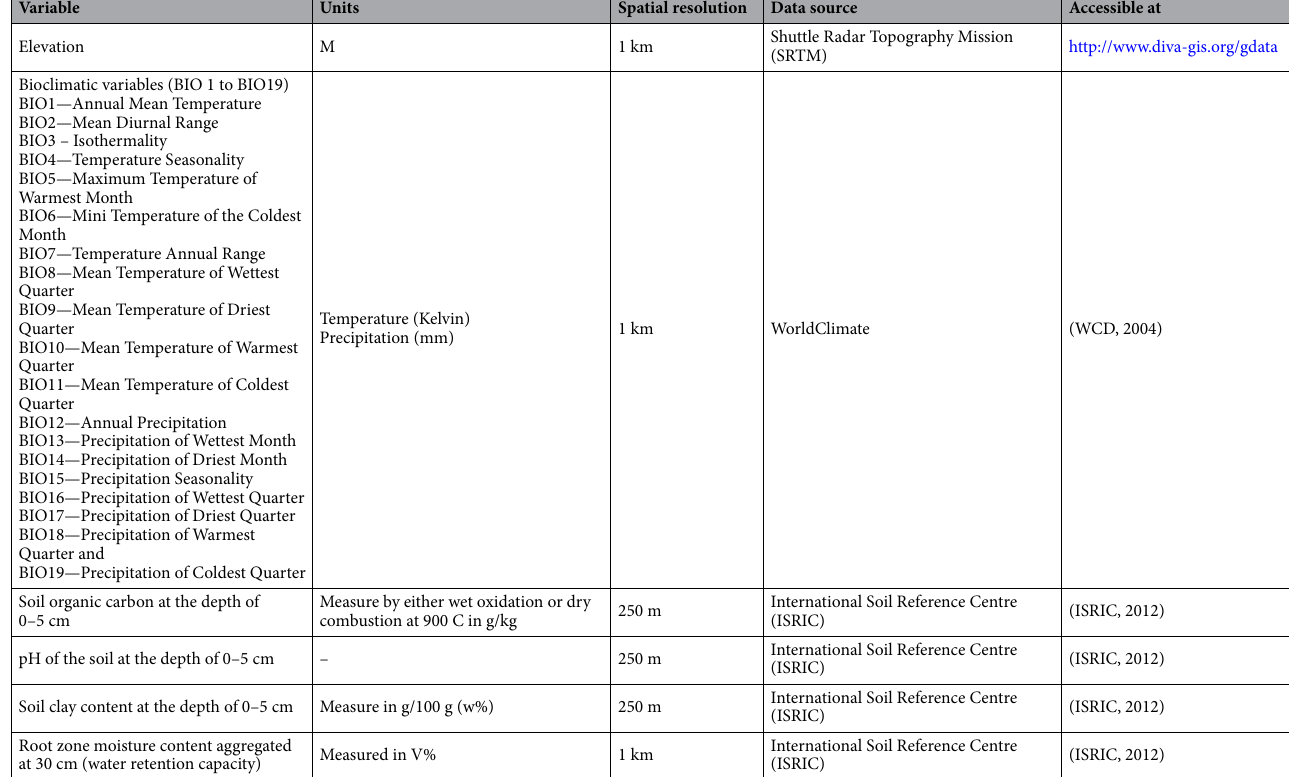
Table 2. Characteristics of Environmental Variables Used in Predicting the Distribution of STHs in